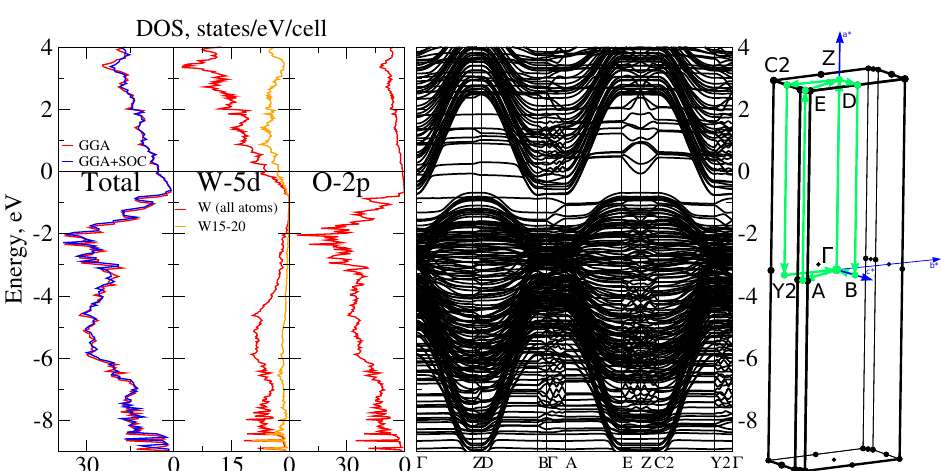
Figure 3. Left: DFT-calculated DOS for W 20 O 58 — total DOS with and without SOC (left section), DOS for tungsten atoms contained in the layers of the edge-shared octahedra (middle section), and DOS for oxygen atoms (right section). Center: DFT-calculated band structure in a wide energy range without SOC. Right: Brillouin zone for W 20 O 58 with the P 2/ m : b space group. Zero corresponds to the Fermi